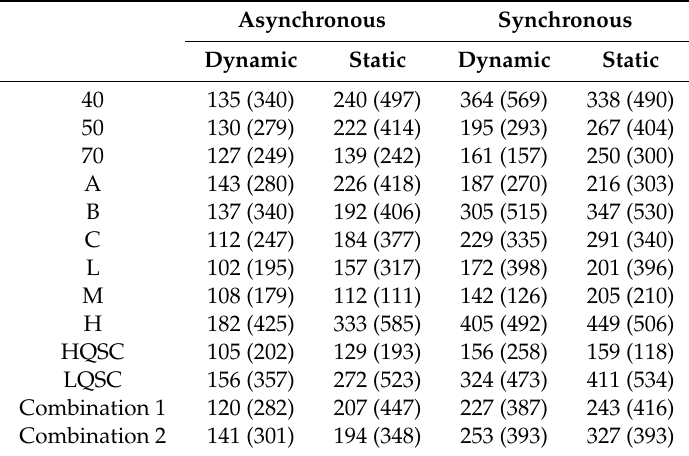
Table 1. Average elapsed time and standard deviation in seconds.